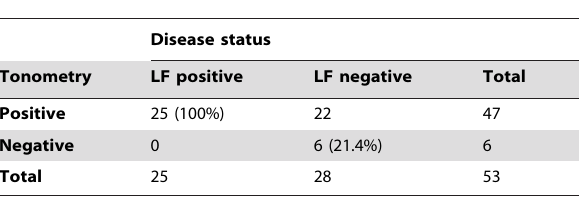
Table 4. Lymphatic Filariasis classification using the suggested tonometric dominant thigh measurement as a screening